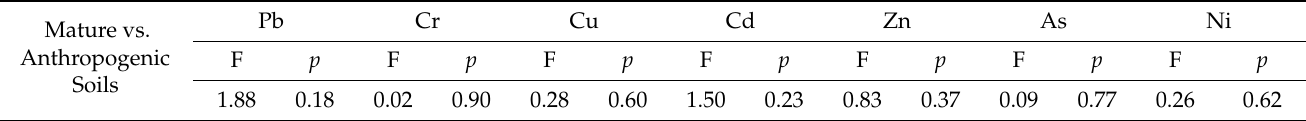
Table 5. Results of MANOVA analysis for trace metals content. Mature